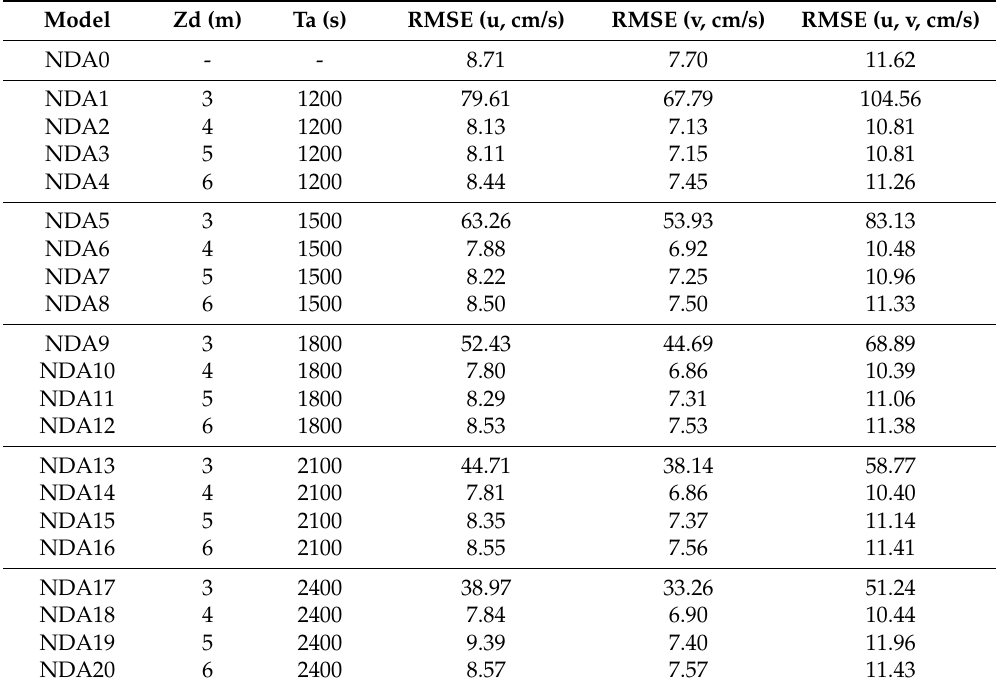
Table 1. Nudging Data Assimilation Test